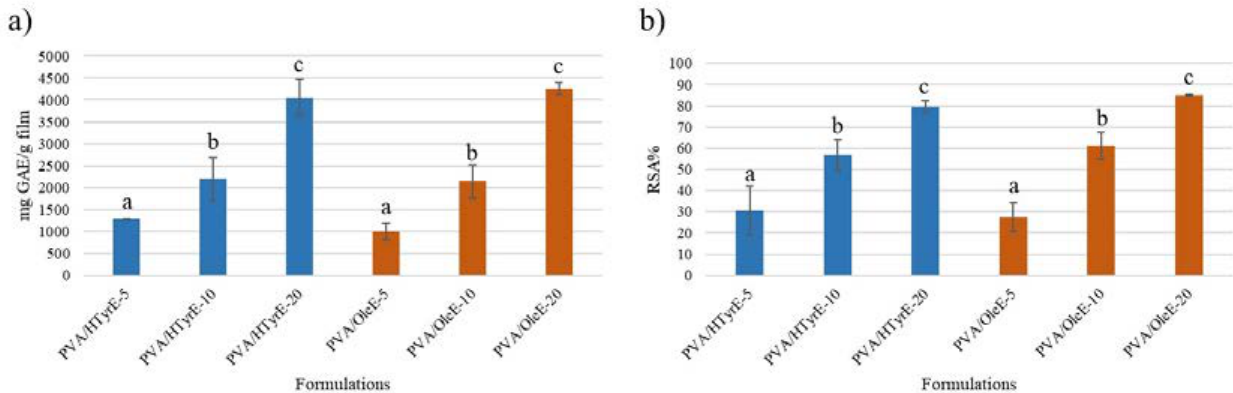
Figure 9. ( a ) Total phenolic content (TPC) and ( b ) antioxidant activity of PVA/HTyrE-5, PVA/HTyrE-10, PVA/HTyrE-20, PVA/OleE-5, PVA/OleE-10 and PVA/OleE-20 formulations determined by Folin–Ciocalteu method and 2,2-diphenyl-1- picryl-hydrazyl-hydrate (DPPH) assay respectively. Results are expressed as mg of gallic acid equivalent (GAE)/g of film for TPC and as radical scavenging activity ( RSA %) for DPPH assay. Significant differences for p ≤ 0.05 were evidenced performing Tukey HSD test and are indicated with different